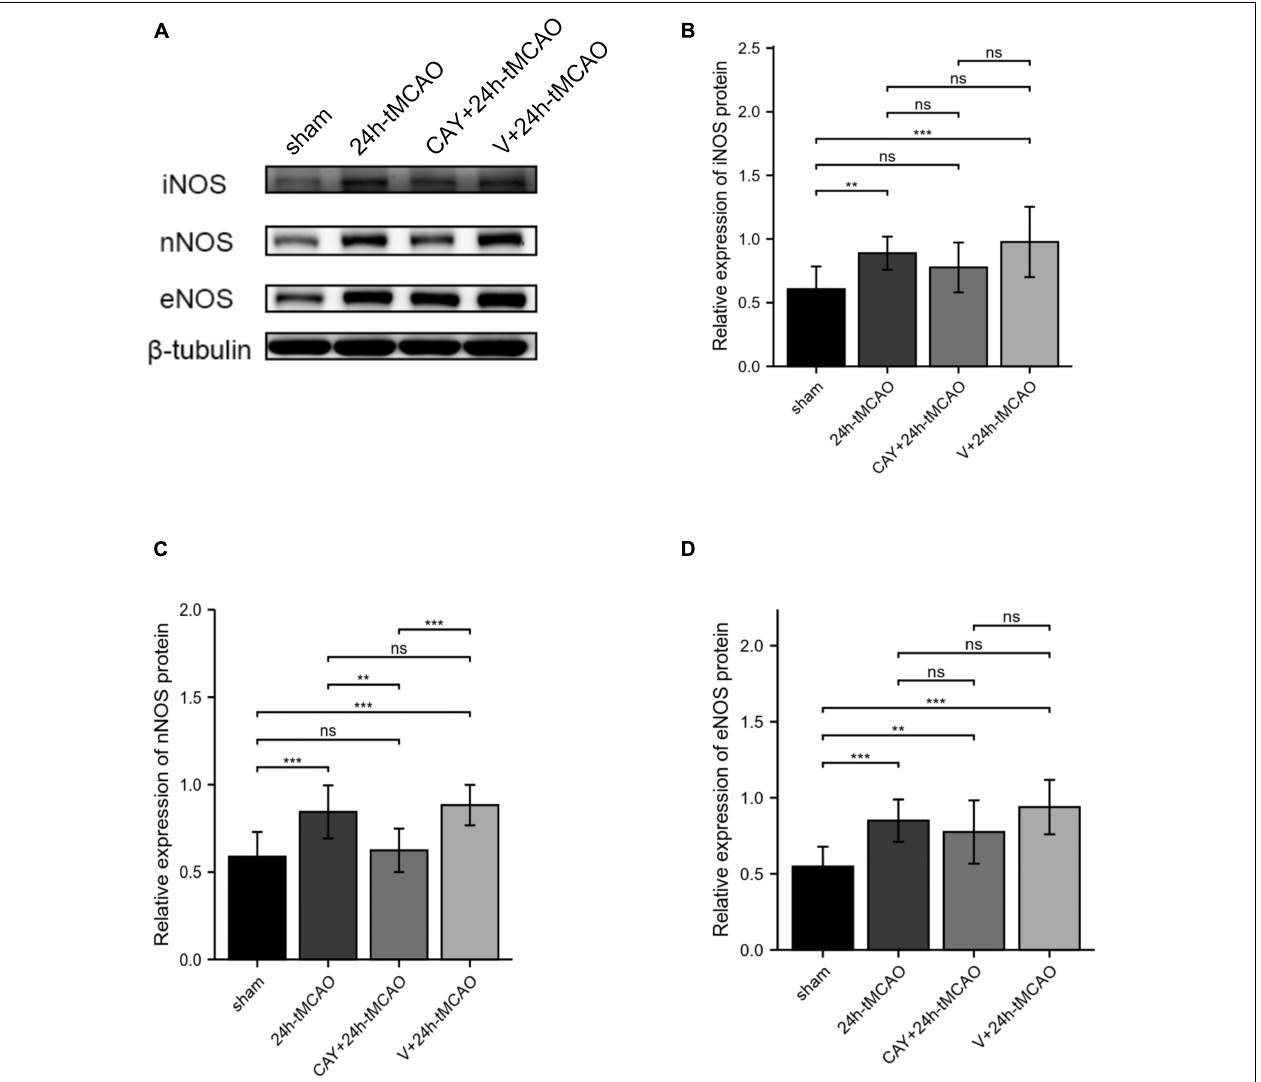
FIGURE 4 | Inhibition of S1PR3 inhibited the expression of nNOS after I/R. (A) Western blot of the sham group, 24 h tMCAO group, CAY10444 + 24 h tMCAO group, V + 24 h tMCAO group, and iNOS, nNOS and eNOS expression. (B–D) The expression levels of iNOS, nNOS and eNOS proteins ( n = 4). Data are presented as the mean ± SEM. P -values were determined by ANOVA followed by the Tukey post hoc test, ** P < 0.01; *** P < 0.001; and ns, not